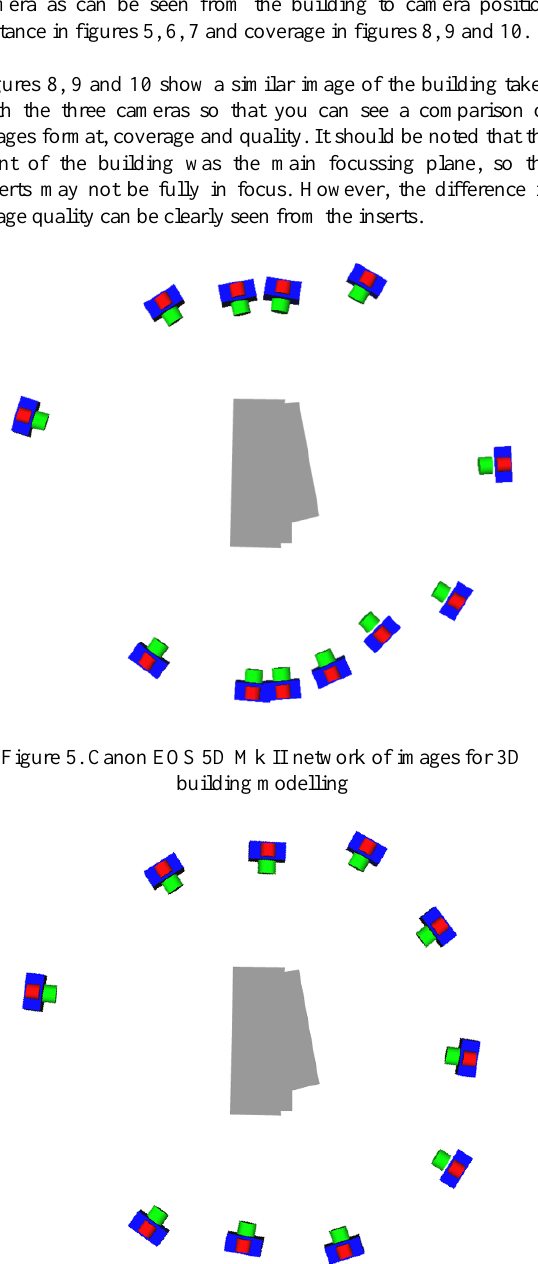
Figure 6. iPhone 4G network of images used for 3D building modelling